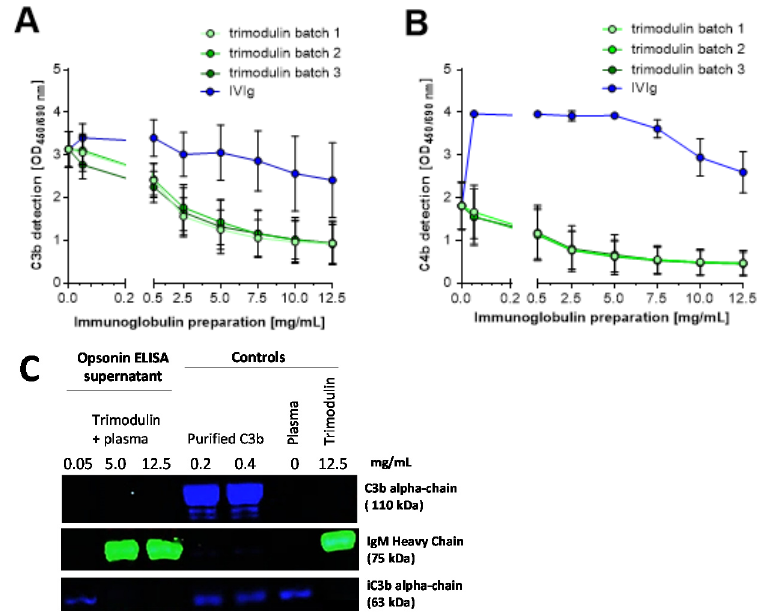
Figure 2. Trimodulin inhibits the detection of the opsonins C3b and C4b concentration-dependently. Opsonin binding assay (ELISA) showing different dilutions of three batches trimodulin (green) and a single intravenous IgG preparation (IVIg) batch (blue). Deposition of ( A ) C3b and ( B ) C4b was detected with an anti-human C3b or C4b antibody, respectively. Data points represent the mean from six independent experiments performed in duplicates. Error bars indicate the standard deviation ( ± SD). ( C ) Western blot analysis of the supernatant of the opsonin ELISA. Loading of the different controls and trimodulin samples on the gel is indicated. C3 fragments (C3b, iC3b, C3c) were detected with a goat anti-human C3c antibody (Dako Agilent, Santa Clara, USA) and a secondary CF488A-labeled donkey anti-goat antibody (blue; Biotium, San Francisco, CA, USA). IgM was detected with a mouse anti-human IgM antibody and a CF588-labeled donkey anti-mouse antibody (green). The plasma control contains EDTA-plasma only, while the trimodulin control contains trimodulin without EDTA-plasma. OD: optical density; ELISA: enzyme-linked immunosorbent